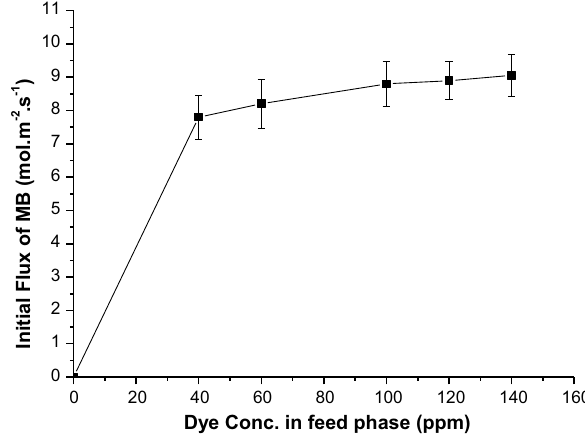
Fig. 8 Transport kinetics of transport process. (a) Concentration pro- file of MB as a function of time; (b) Kinetic plot for transport of MB by PIMs. (Experimental conditions: Feed phase:100 mg/L MB solu- Table 4 Effect of acid concentration in the stripping phase